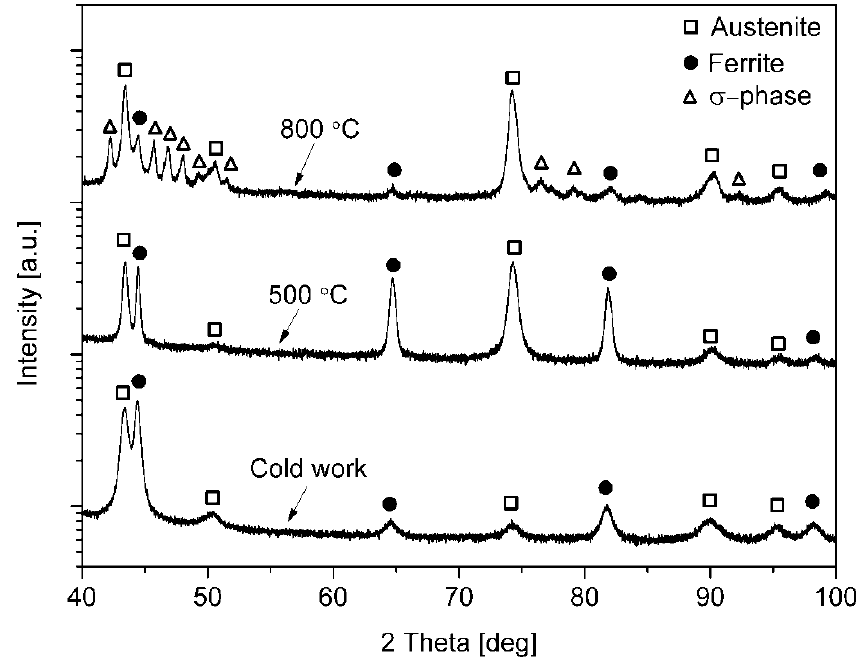
Figure 6. X-ray di ff ractogram in logarithmic intensity scale of the cold worked (60%), the cold worked Figure 6. X-ray diffractogram in logarithmic intensity scale of the cold worked (60%), the cold (60%) then heat treated at 500 ◦ C, and the cold worked (60%) then heat treated at 800 ◦ C worked (60%) then heat treated at 500 °C, and the cold worked (60%) then heat treated at 800 °C samples.